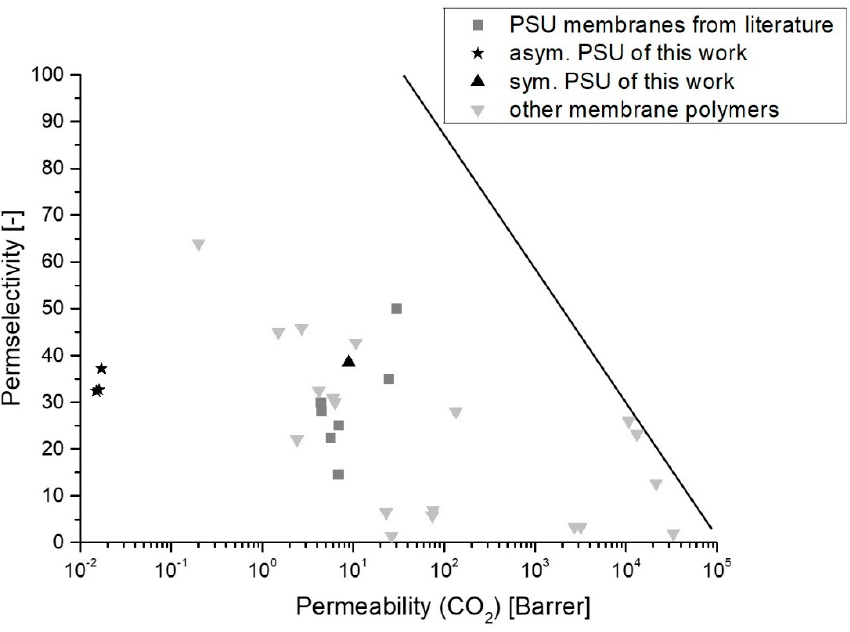
Figure 8. Robeson plot for data from this work and several membrane materials, including PSU membranes from different literature sources [4,15,56 − 60]. Dark grey squares ( ■ ) mark PSU membranes from the literature, black stars (*) mark asymmetric PSU membranes of this work, the black triangle directed upwards ( ▲ ) marks the PSU30_EIPS membranes of this work and light grey triangles directed downwards ( ▼ ) mark other membrane polymers from literature. The black line marks the Robeson upper bound from 2008 [61].